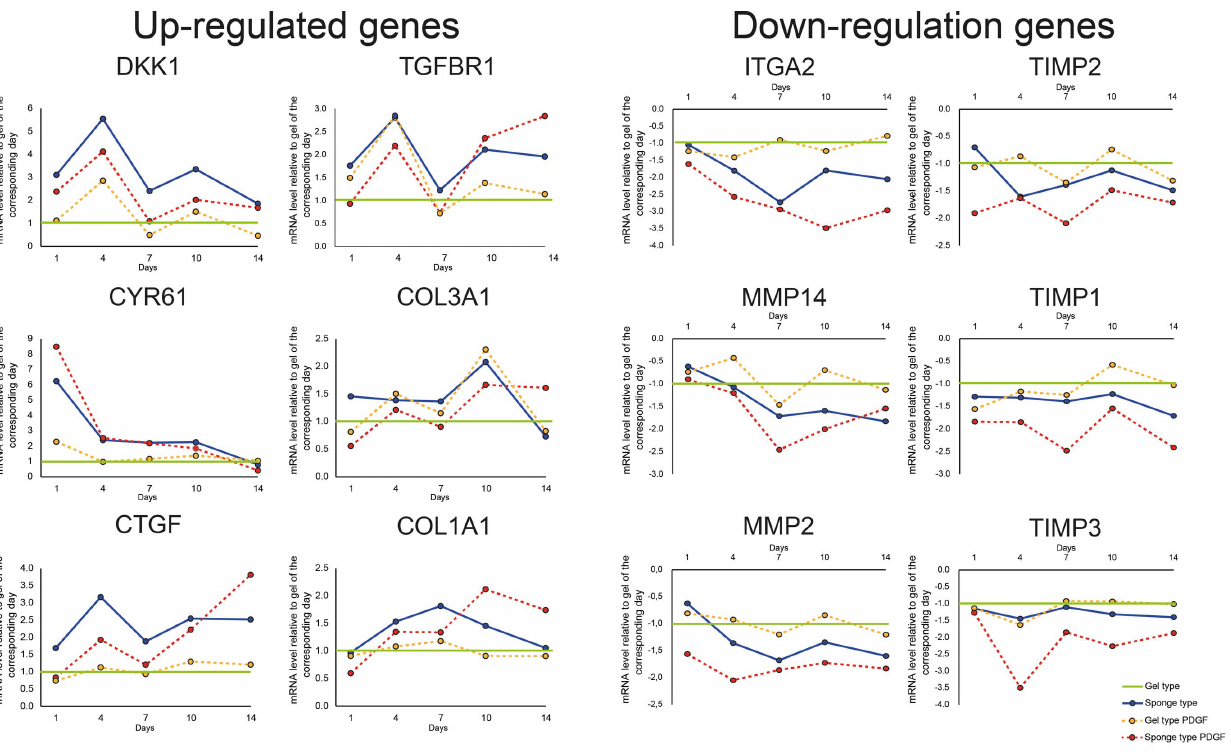
Figure 6. Gene expression profiles of DKK1, CYR61, CTGF, TGFBR1, COL3A1, COL1A1, ITGA2, MMP14, MMP2, TIMP2, TIMP1, TIMP3. The expression profiles of DKK1, CYR61, CTF, TGFBR, COL3A1, COL1A1 and ITGA2, MMP14, MMP2, TIMP2, TIMP1, TIMP3 up to 14 days in the gel type and sponge type scaffolds with and without platelet-derived growth factor-BB (PDGF) was measured using qPCR. (Up-regulated genes) Data shows x- fold increase of DKK1, CYR61, CTF, TGFBR, COL3A1, COL1A1 relative to gel type scaffold without PDGF at the corresponding time point (green line). (Down-regulated genes) Data shows x-fold decrease of ITGA2, MMP14, MMP2, TIMP2, TIMP1, TIMP3 relative to gel type scaffolds without PDGF at the corresponding time point (green line). Data points represent 5